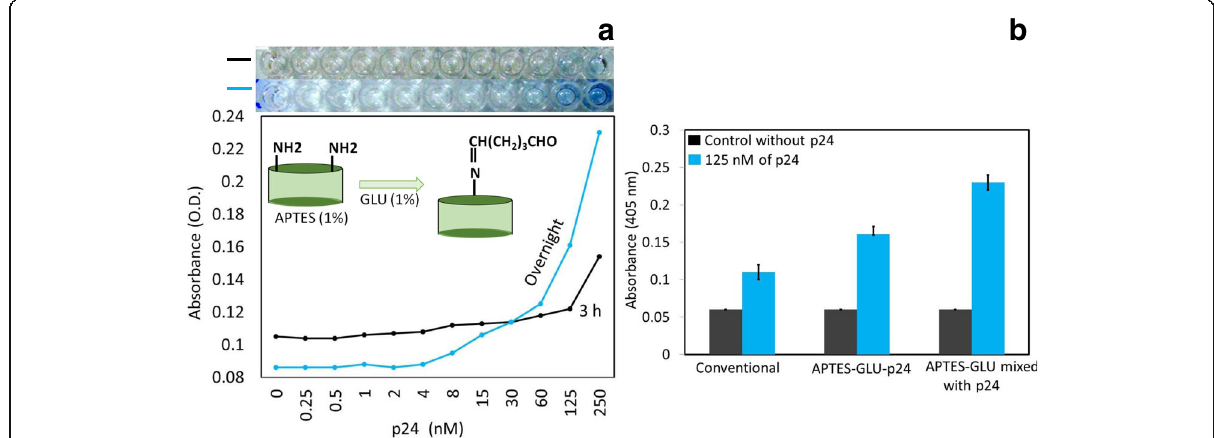
Fig. 4 Optimization of the incubation period for GLU. a Optimized to have an incubation period of 3 h and an overnight incubation using 1%